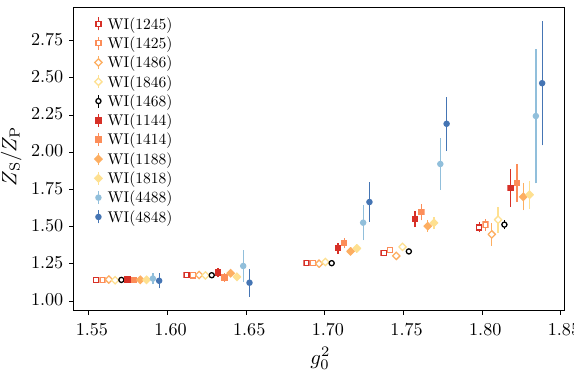
Fig. 4 Dependence of Z S / Z P on the gauge coupling g 2 obtained from the 11 Ward identity classes listed in Table 3. Open symbols are used for the Ward identity classes with connected-quark diagrams only; closed symbols denote Ward identity classes with both connected- and disconnected-quark diagrams. Closely related Ward identities (which are separated by a single horizontal line in Table 2) are shown with the same symbol. Data from WI(1144) are shown at their exact abscissa position, while the others have been slightly displaced in the g 2 -direction, in order to improve 0